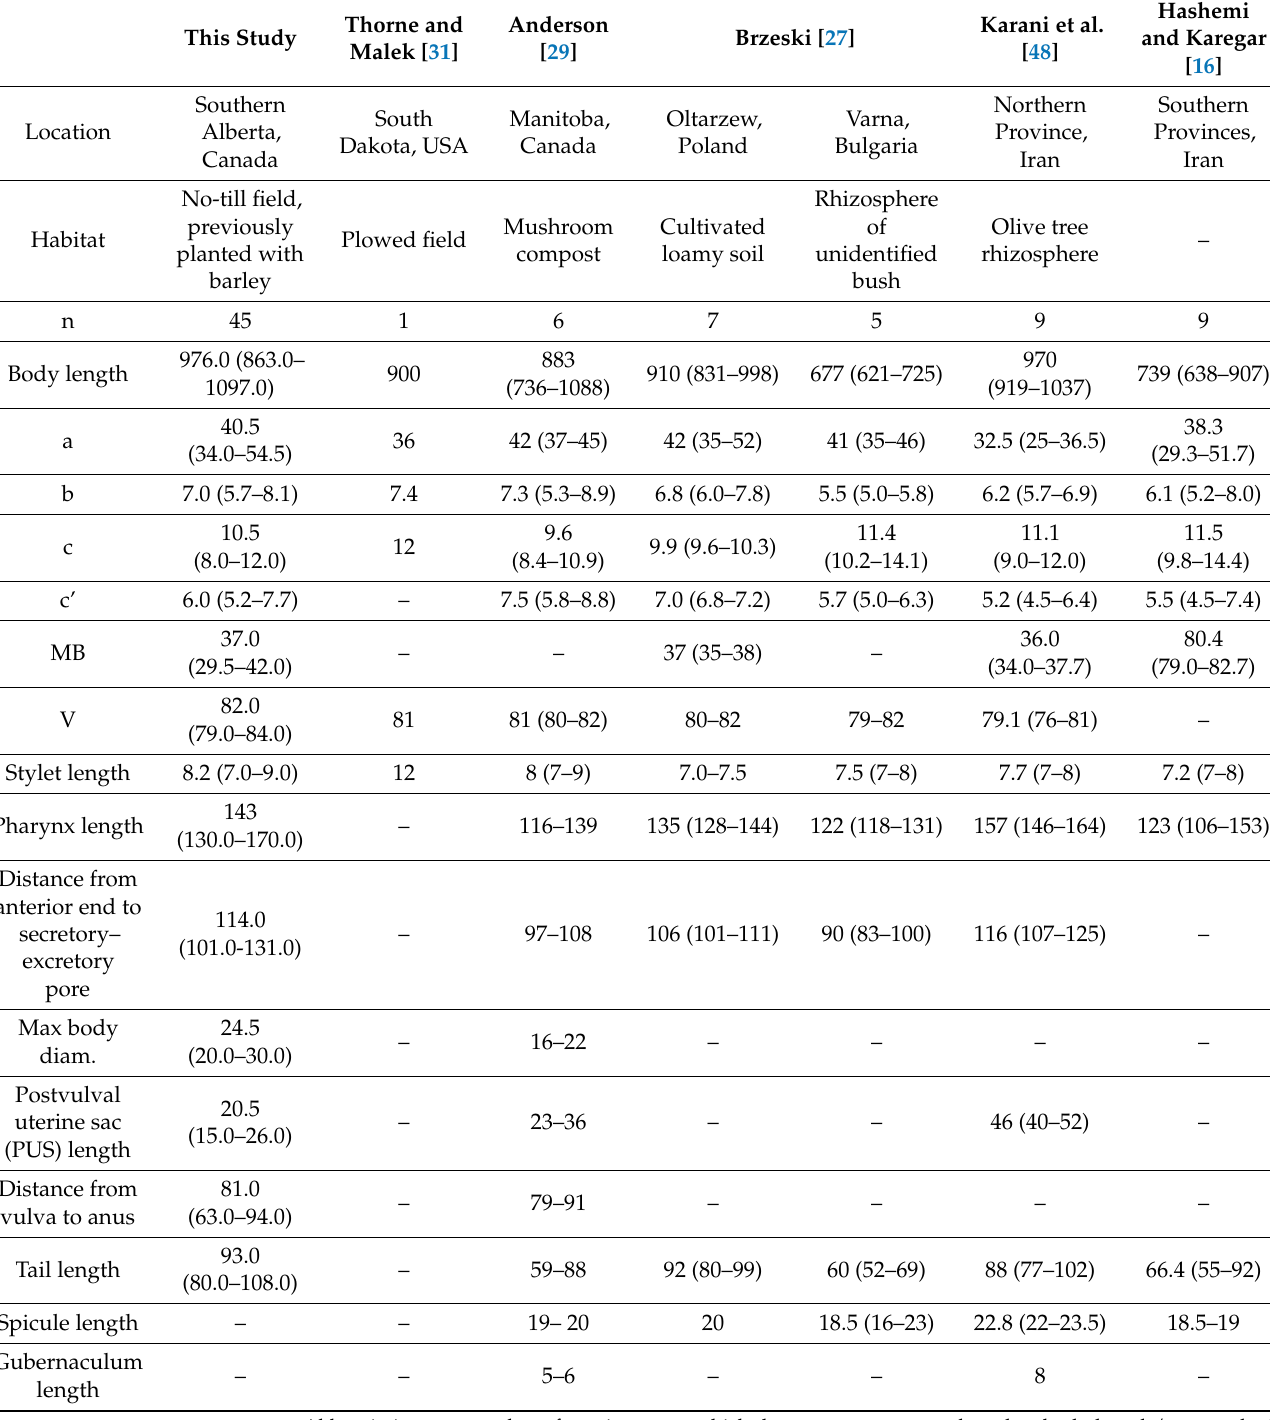
Table 6. Comparative morphometrics of all the reported populations of Ditylenchus valveus (female) Thorne and Malek [31]. All measurements are in µ m and in the form: the mean (range) or mean (South